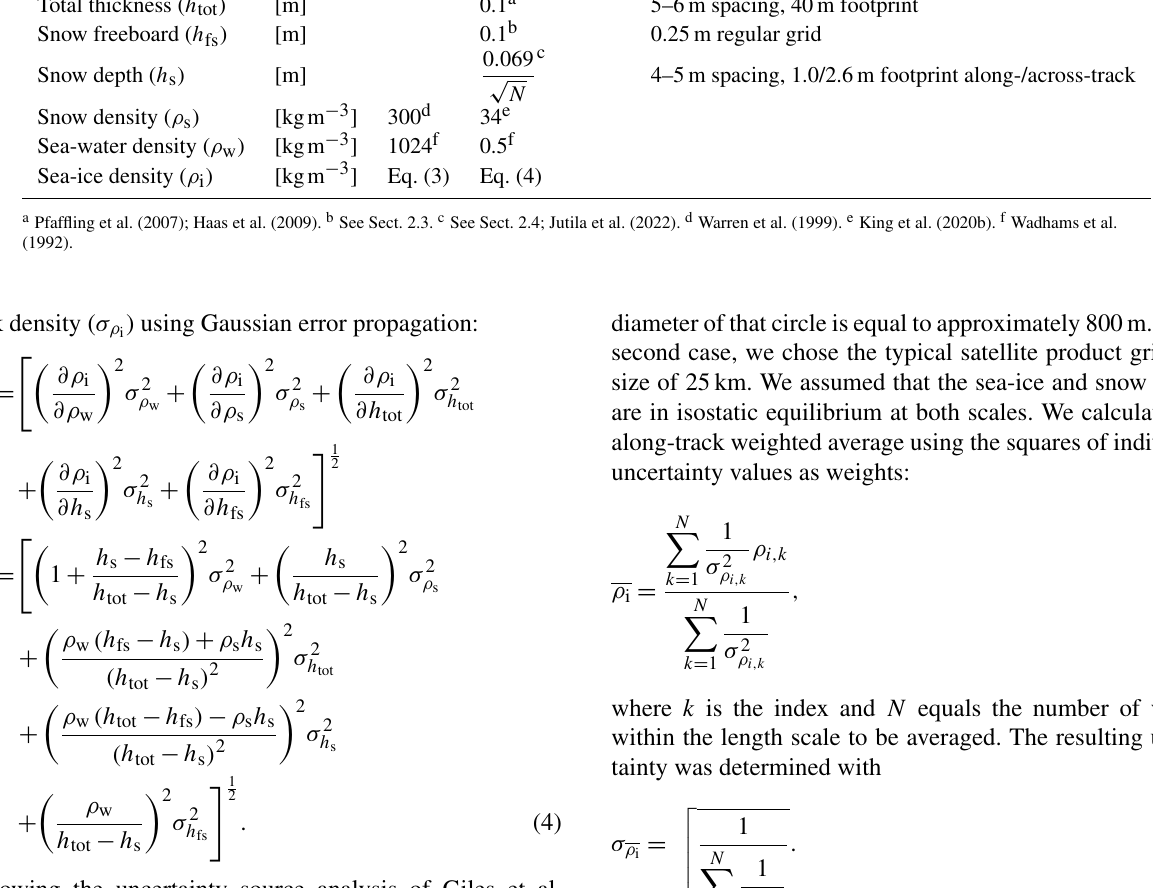
Table 2. Summary of the key variables and their assumed values, uncertainties, and resolutions.